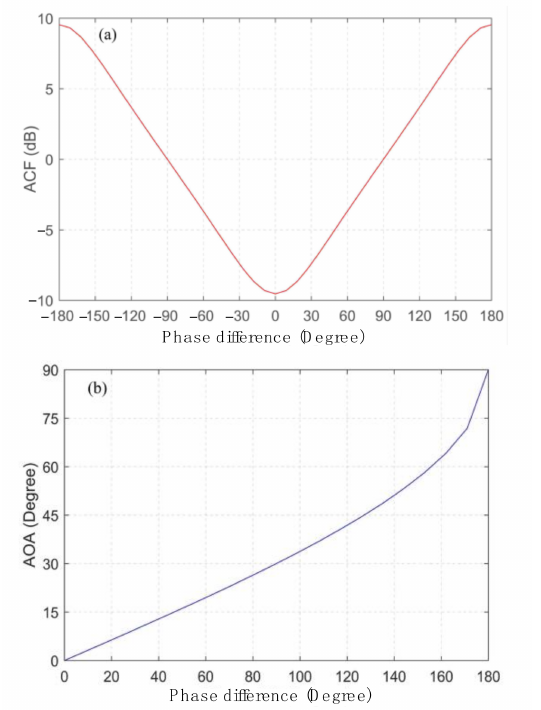
Figure 3. ( a ) Theoretically calculated ACF as the phase difference is changed from − 180 ◦ to 180 ◦ . ( b ) The relationship between the AOA and phase shift within 180 ◦